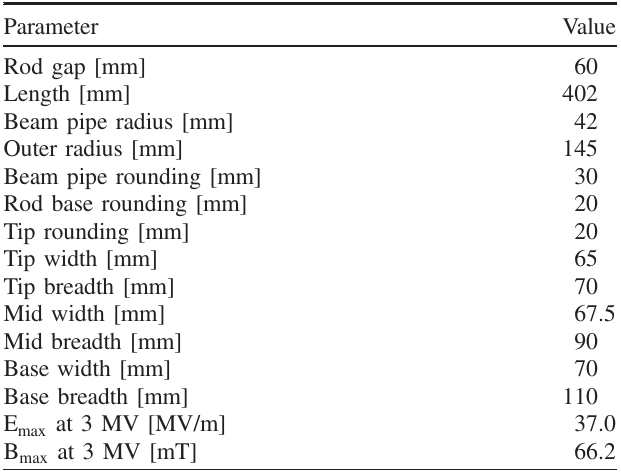
TABLE II. A table of design parameters of the control elliptical conical cavity design [24].